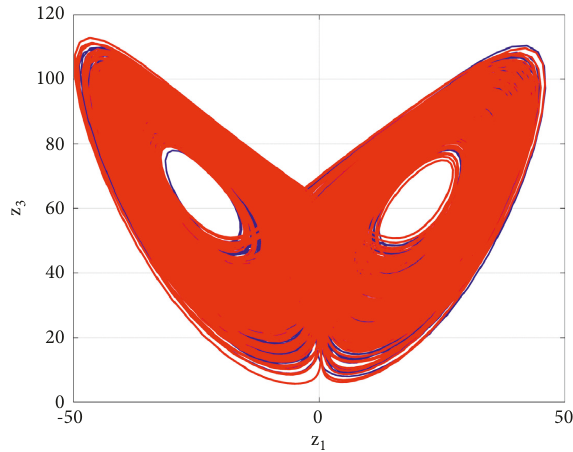
Figure 26: The coexistence of one periodic and one chaotic attractor for system (1) projected in the ( z for the choice of parameters ( a,b, c, d ) � ( 25 , 8 , 32 , 6 ) .